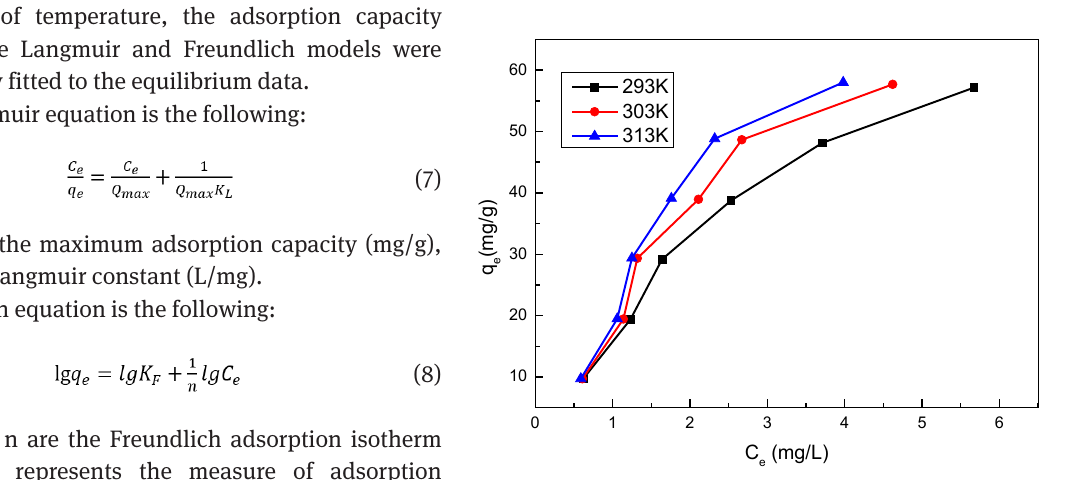
Figure 11: Cu 2+ adsorption isotherms on the fermented Magnolia officinalis residues.